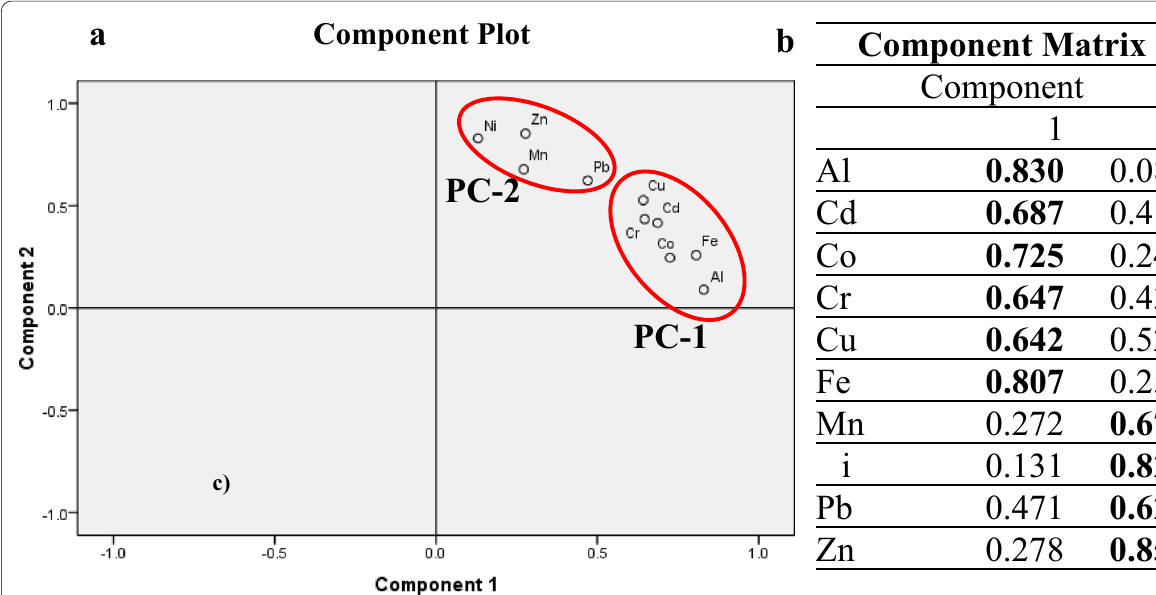
Fig. 5 Principal component analysis of PTEs. a Component plot (VARIMAX rotation); b component